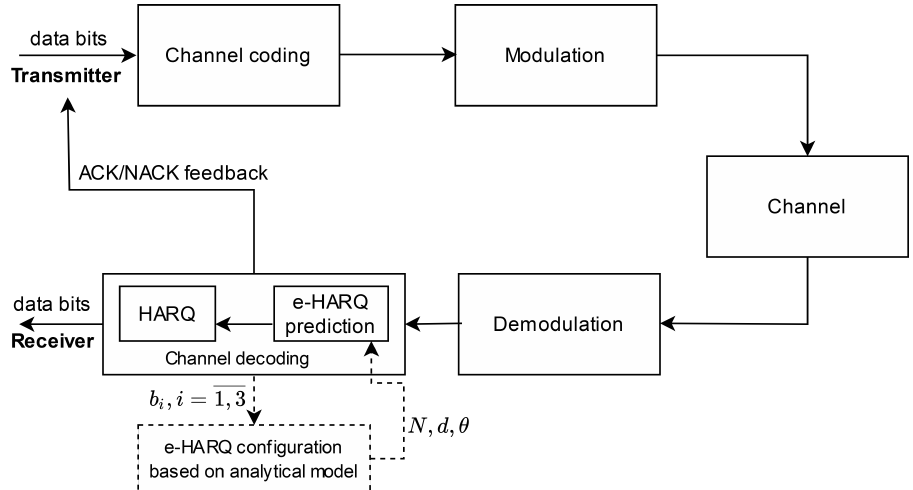
Figure 4. Block diagram of a considered communication system on a high-level